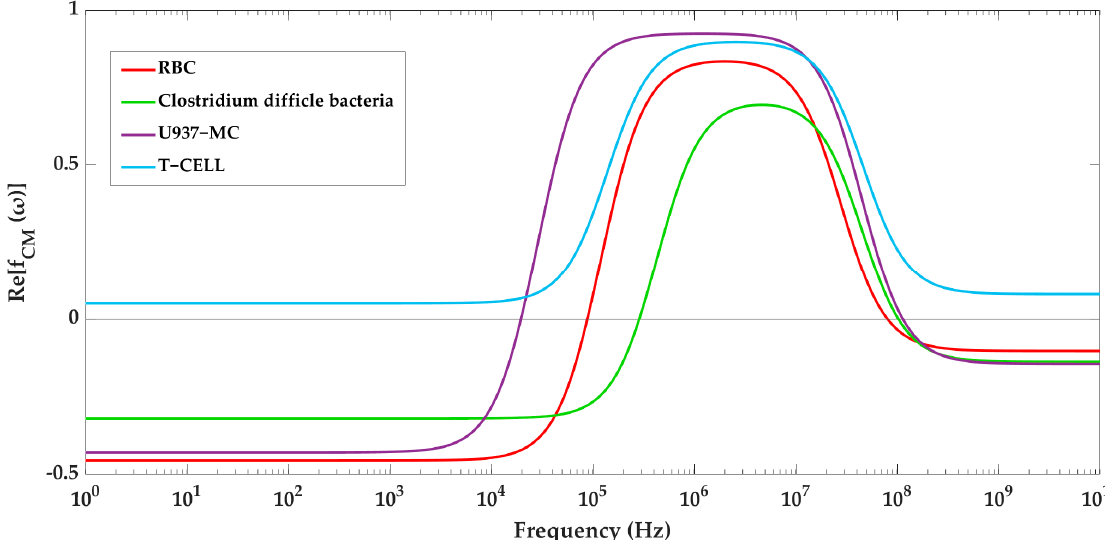
Figure 7. The real part of CM factor for the